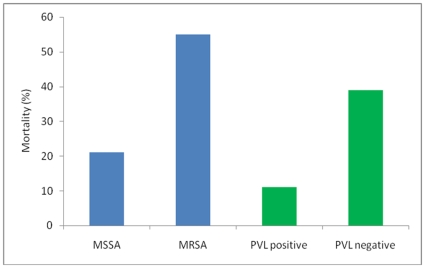
Higher all-cause mortality associated with methicillin-resistant S. aureus (MRSA) but not with Panton-Valentine Leukocidin (PVL).Patients infected by MRSA had a greater all-cause mortality compared with patients infected by methicillin-susceptible S. aureus (MSSA) (p<0.001). Conversely, patients infected by PVL gene-positive S. aureus had a lower all-cause mortality compared with patients infected by PVL gene-negative S. aureus (p<0.001), an association that remained after adjustment for MRSA (p = 0.001).